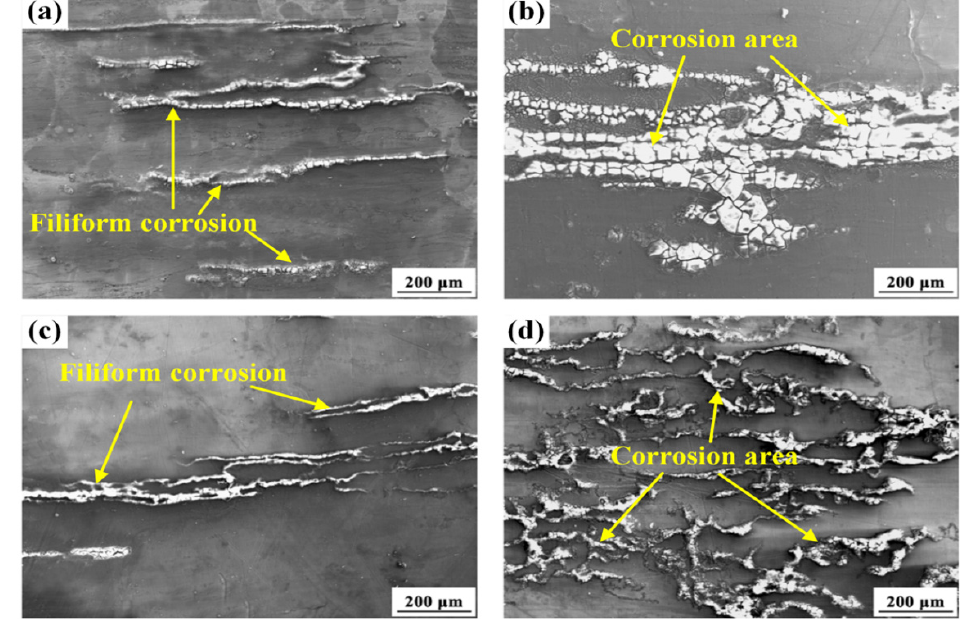
Figure 10. SEM images of ( a ) ZK60E, ( b ) ZK60E-250, ( c ) ZK60EF-300, and ( d ) ZK60EF-450 alloy after salt spray corrosion for 4 h.